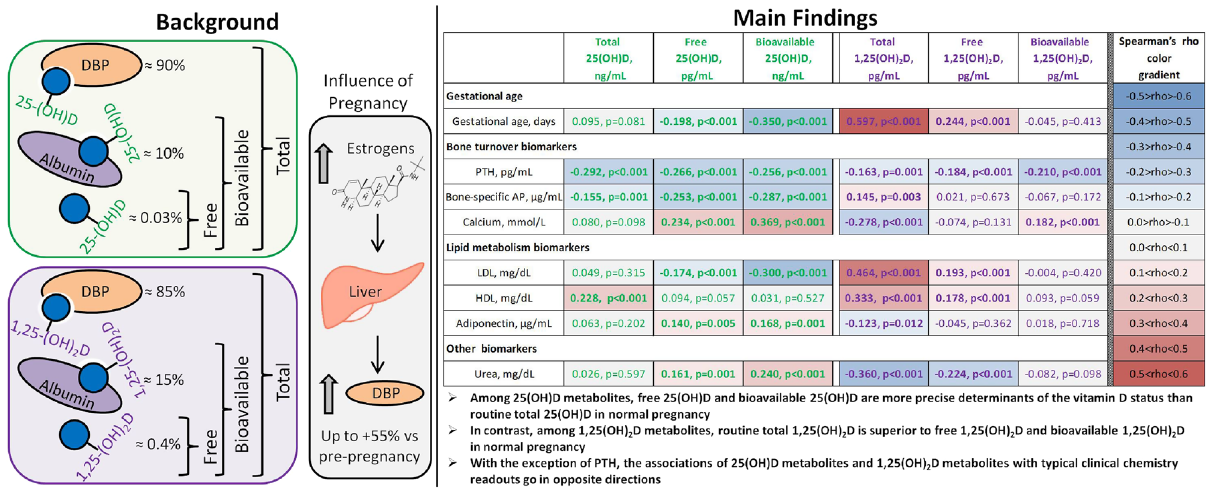
Figure 1. Key findings of our study are: (i) Both free 25(OH)D and bioavailable 25(OH)D showed better correlations with gestational age, bone and lipid metabolism biomarkers than total 25(OH)D. (ii) Total 1,25(OH) 2 D is superior to free 1,25(OH) 2 D and bioavailable 1,25(OH) 2 D. (iii) 25(OH)D metabolites and 1,25(OH) 2 D metabolites correlated with gestational age, bone and lipid biomarkers in opposite